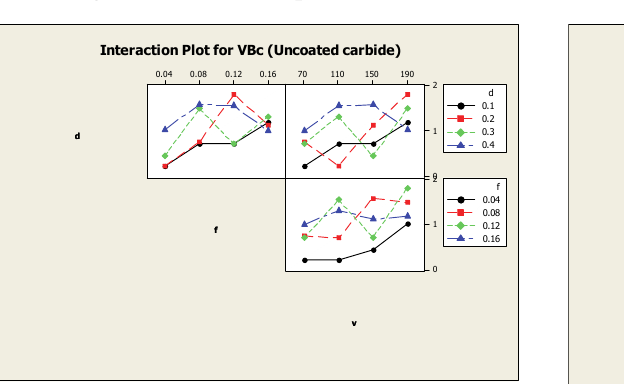
Fig. 4. Main effects plot for VBc Fig. 5. Main effects plot for Ra